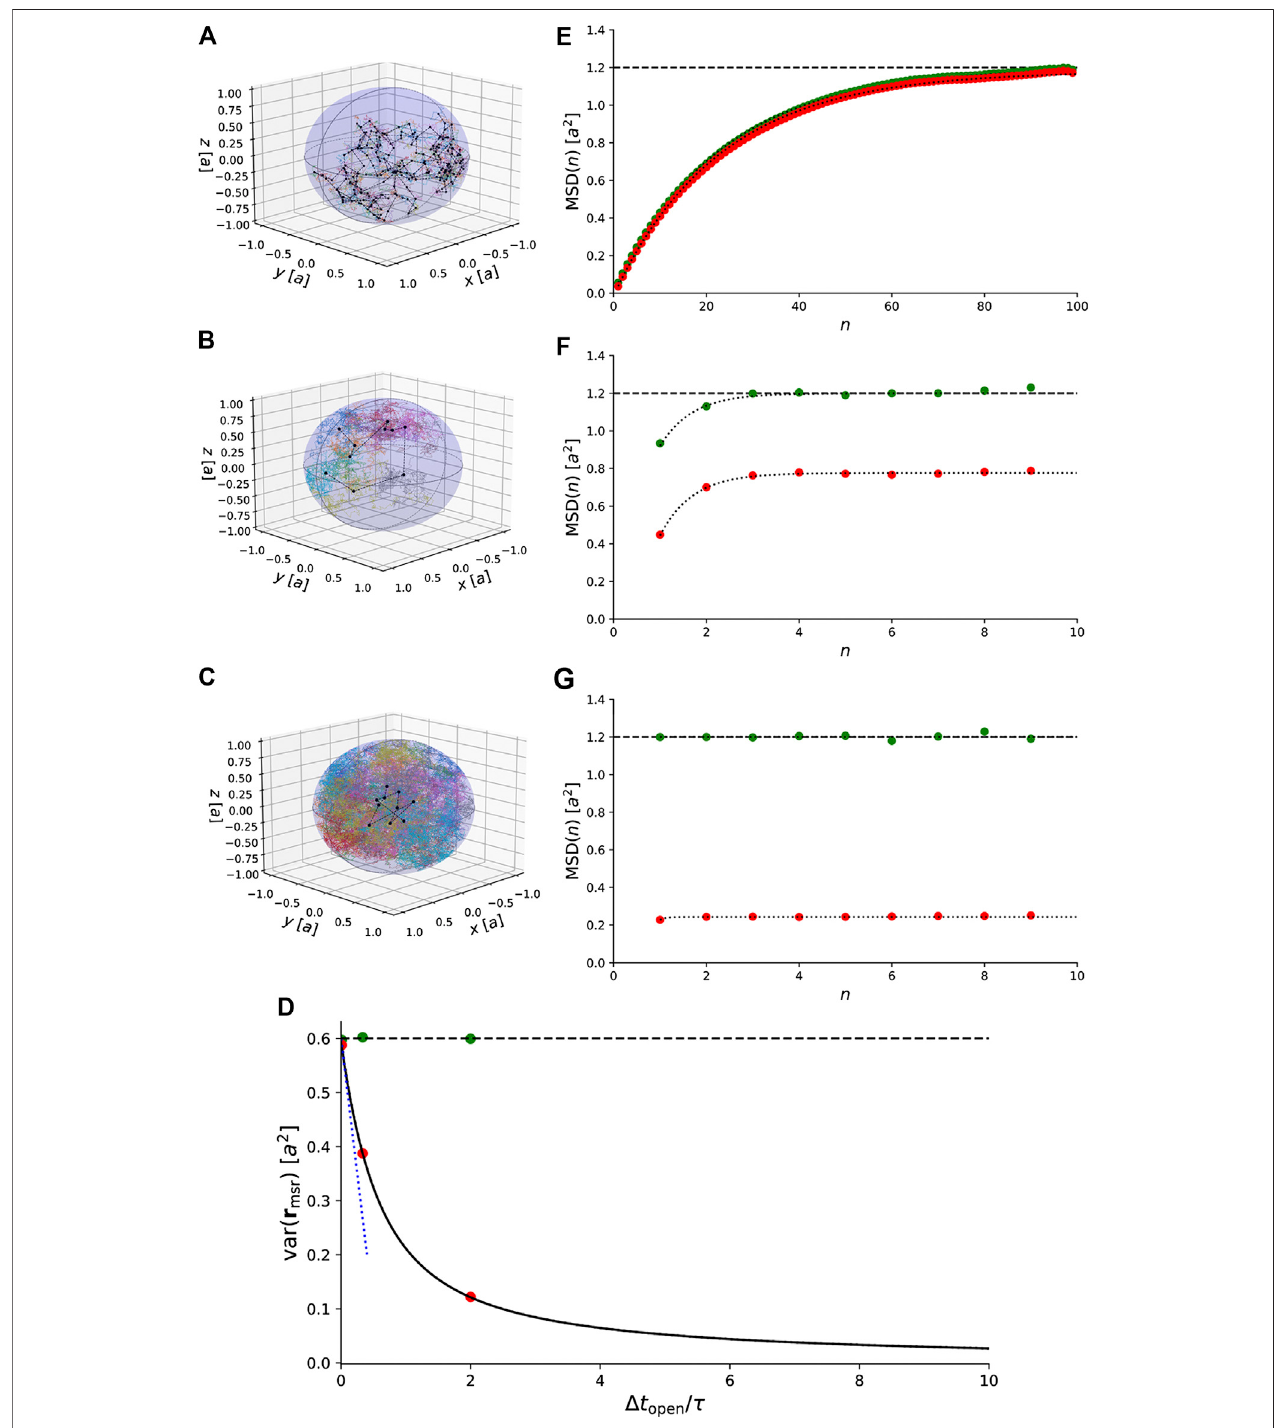
FIGURE 5 | Simulations of 3D Brownian motion con fi ned to a spherical domain with radius a . (A) – (C) Simulated trajectories for Δ t / τ (cid:2) 0.01, 0.33, and 2, respectively, and Δ t (cid:2) Δ t open . The measured positions including the effect of motion blur are indicated (black dots connected by dashed lines). The underlying positions visitedbytheparticleduringeachframeinthetime-lapsemovieareshownwithdifferentcolorforeachframe,plottedontopofeachotherwiththelatestframeontop. (D) Varianceforthesamevaluesoftheratio Δ t / τ asinpanels (A) – (C) (reddots).Dottedcurves:theexactresultforthevariancein Eq.35 (black),theapproximateresult in Eq. 36 valid for Δ t open ≪ τ (blue). Horizontal black dashed line: variance (cid:2) 3 a 2 / 5, the value for Δ t open / τ → 0. (E) – (G) Mean-squared displacements (MSDs) for Δ t / τ (cid:2) 0.01, 0.33, and 2, respectively, and with Δ t (cid:2) Δ t open . Colored dots: measured positions excluding (green) and including (red) the effect of motion blur. Dotted